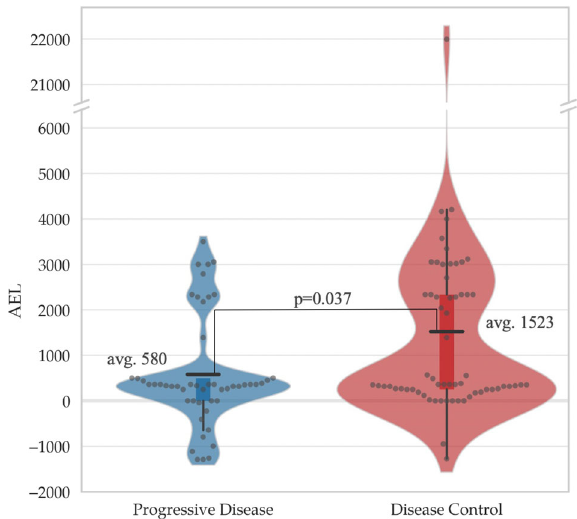
Fig. 3 Association between digital drug assignment (DDA) and disease control of molecularly targeted agents (MTAs) in the SHIVA01 trial. Average aggregated evidence level (AEL) score of MTAs in patients with progressive disease and patients achieving disease control (DCR) (stable diseased and partial